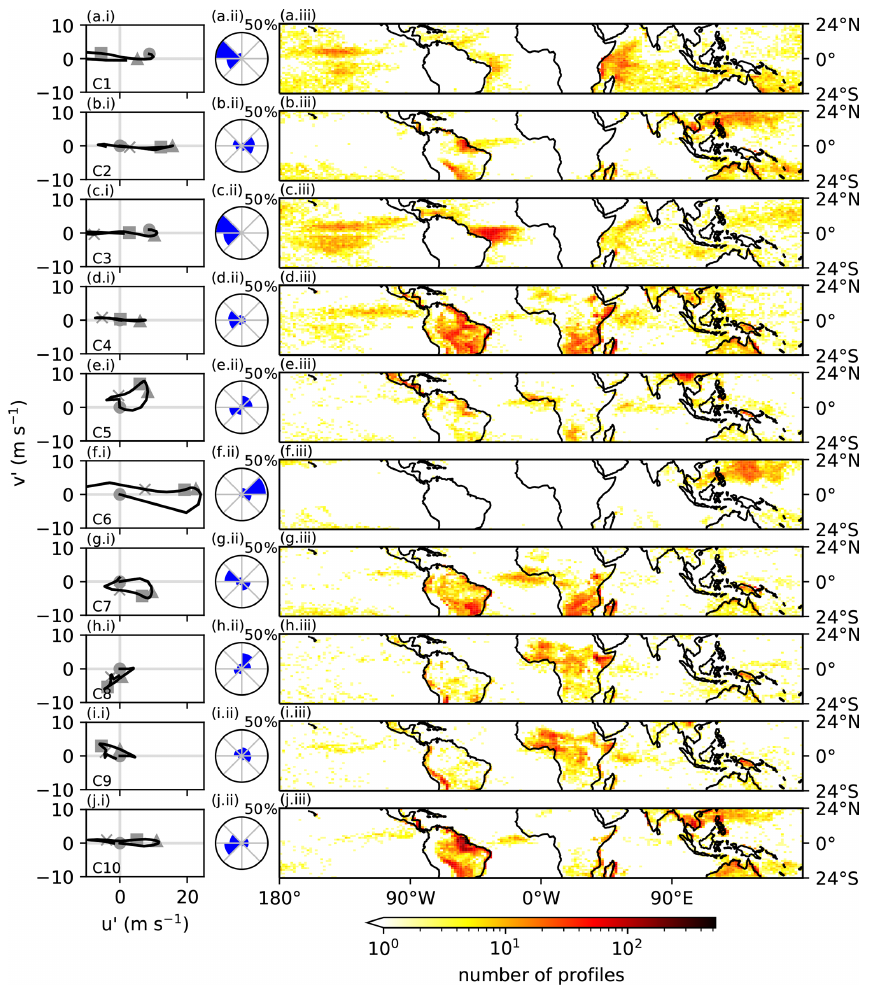
Figure 5. Left column: hodographs of the 10 RWP clusters, showing the u (cid:48) and v (cid:48) winds as in Fig. 4. The circle, square, triangle and cross show levels of 1000, 750, 500 and 250hPa respectively. Centre column: wind rose of distributions of the wind direction at 850hPa. (Note that these show the direction in which the wind at 850hPa is blowing; i.e. for C3 the 850hPa wind is to the west or easterly as can be seen from c.ii .) Right column: heat maps of the distributions of each RWP across the tropics, showing the total number of profiles for each RWP at each grid